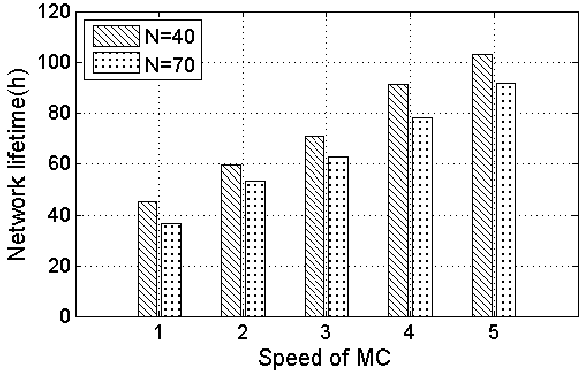
Figure 6. The effect of different moving speeds of the MC on the network lifetime.